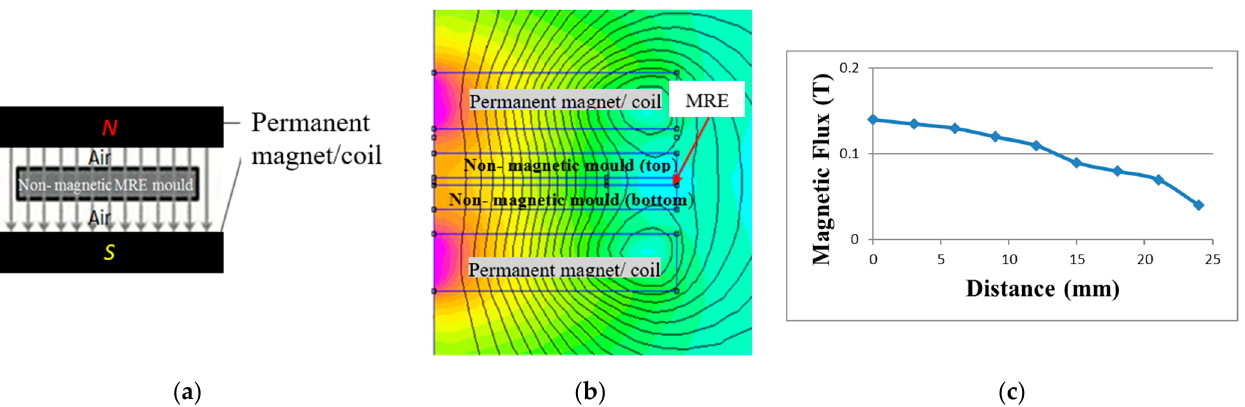
Figure 3. Simulation of magnetic flux density using FEMM of commonly used in previous studies: ( a ) Schematic drawing of the curing setup ( b ) distribution ( c ) value of magnetic flux across the MRE sample.